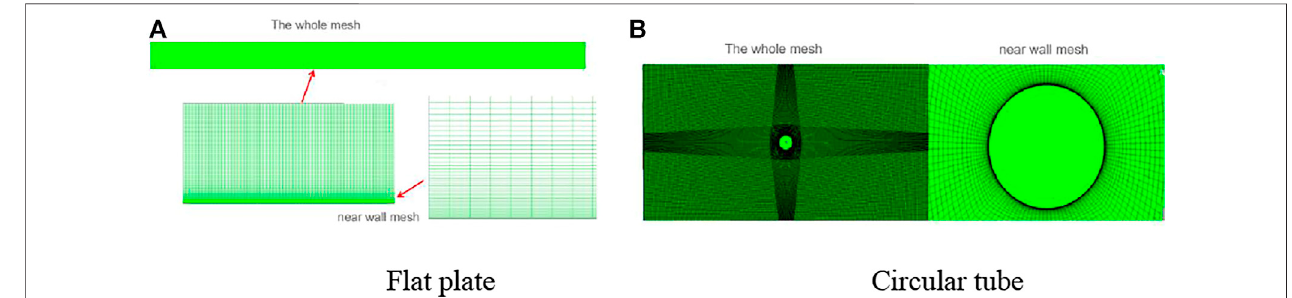
FIGURE 1 | Grid distribution of the convective heat transfer models. (A) Flat plate and (B) Circular tube.